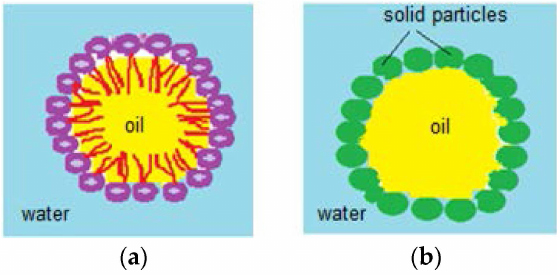
Figure 15. ( a ) Oil/water emulsion; ( b ) Pickering oil/water emulsion.